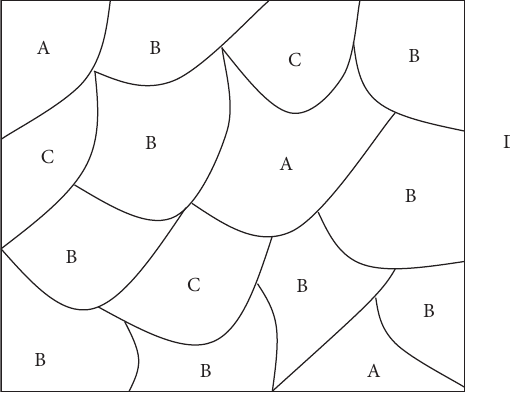
Figure 1: Abridged general view of farmland distribution in a village.